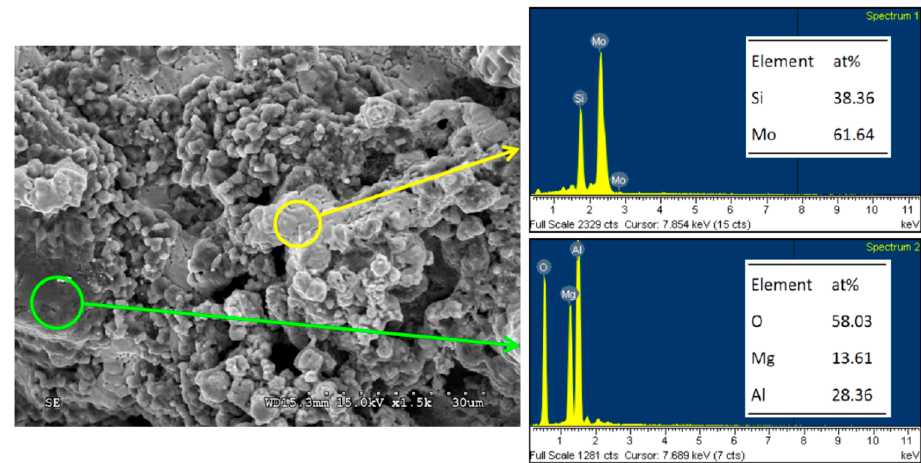
Figure 9. SEM image with EDS element spectra of Mo 5 Si 3 –MgAl 2 O 4 composite synthesized from R(2) with y = 3.